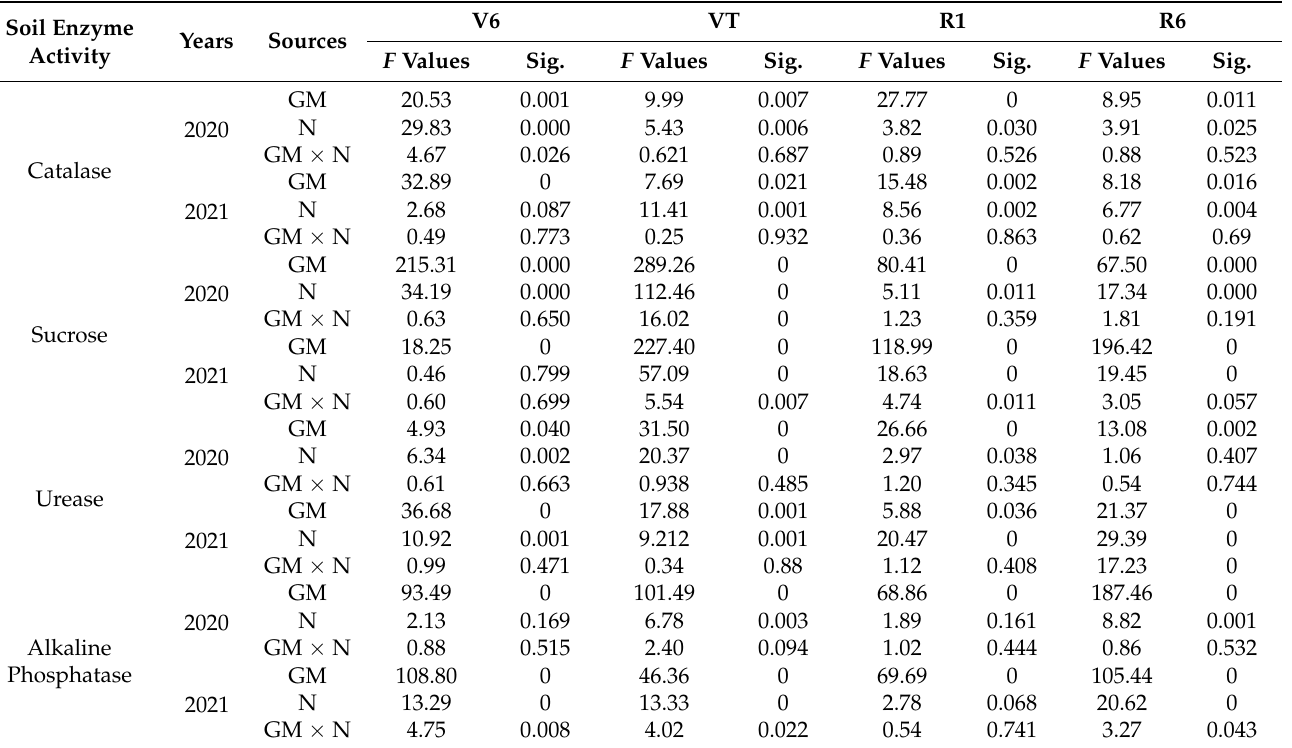
Table 4. The ANOVA for soil catalase, sucrose, urease, and alkaline phosphatase activity at different growth stages under WF and GM treatments in 2020 and